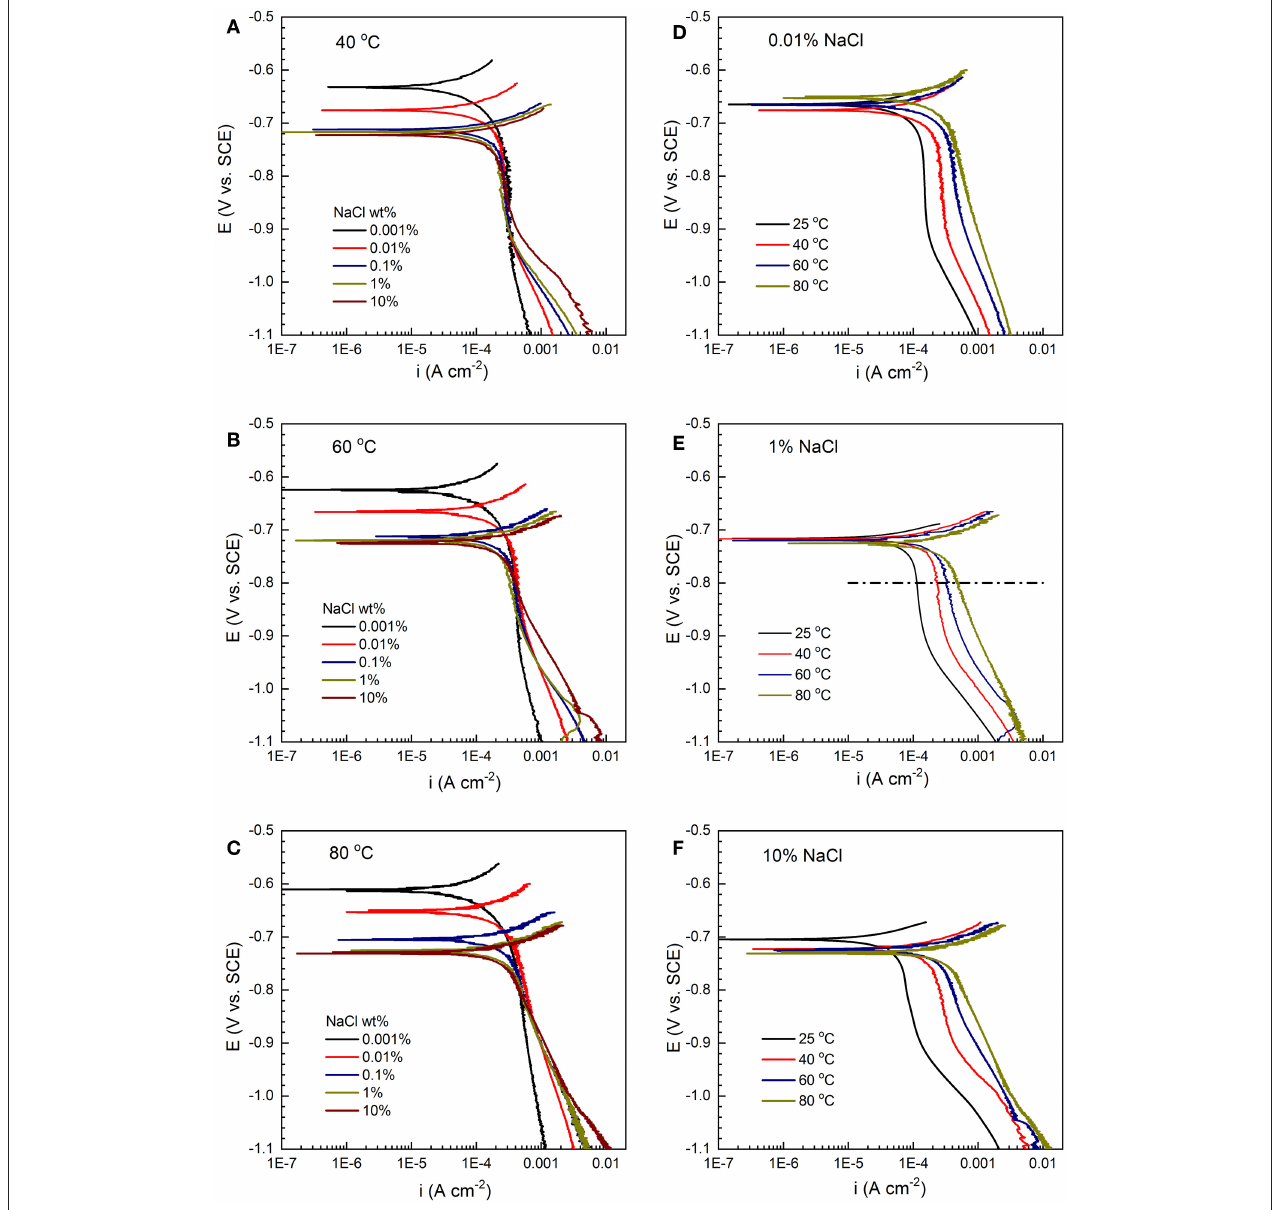
FIGURE 12 | Cathodic polarization curves of C1010 steel with varying salt concentration (0.001% to 10%) at constant temperature levels, (A) 40 ◦ C, (B) 60 ◦ C, and (C) 80 ◦ C. Cathodic polarization curves with varying temperature (25 to 80 ◦ C) at constant salt concentration levels, (D) 0.01%, (E) 1%, and (F) 10%.